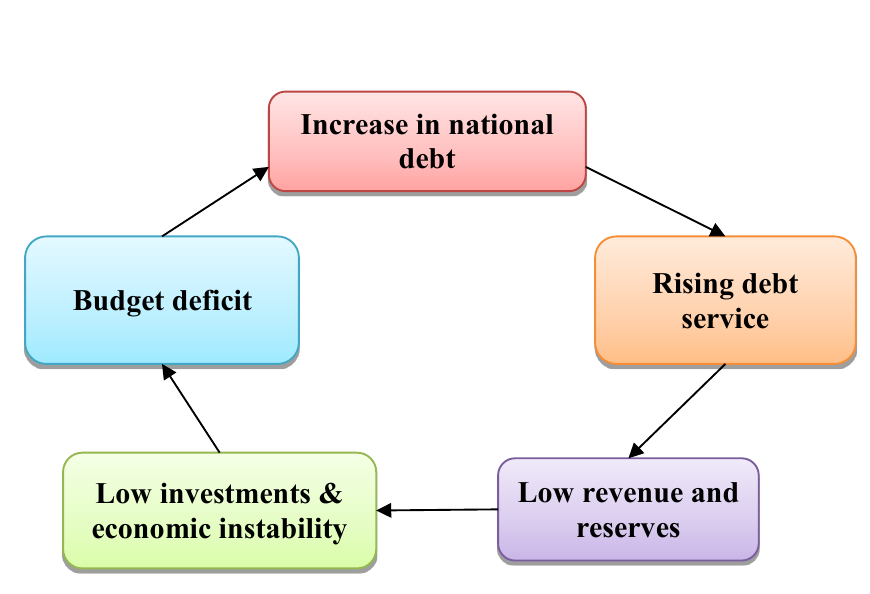
Fig. 2. Debt-economic instability relationship (Developed by the authors, 2021).